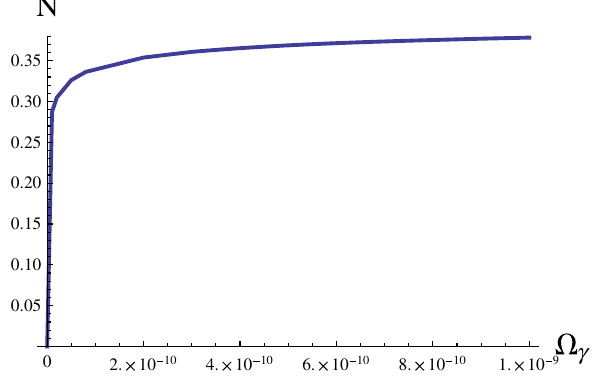
Fig. 16 Diagram of the relation between positive (cid:3) γ and the approx- imate number of e-foldings N = H init ( t fin − t init ) from t init to t